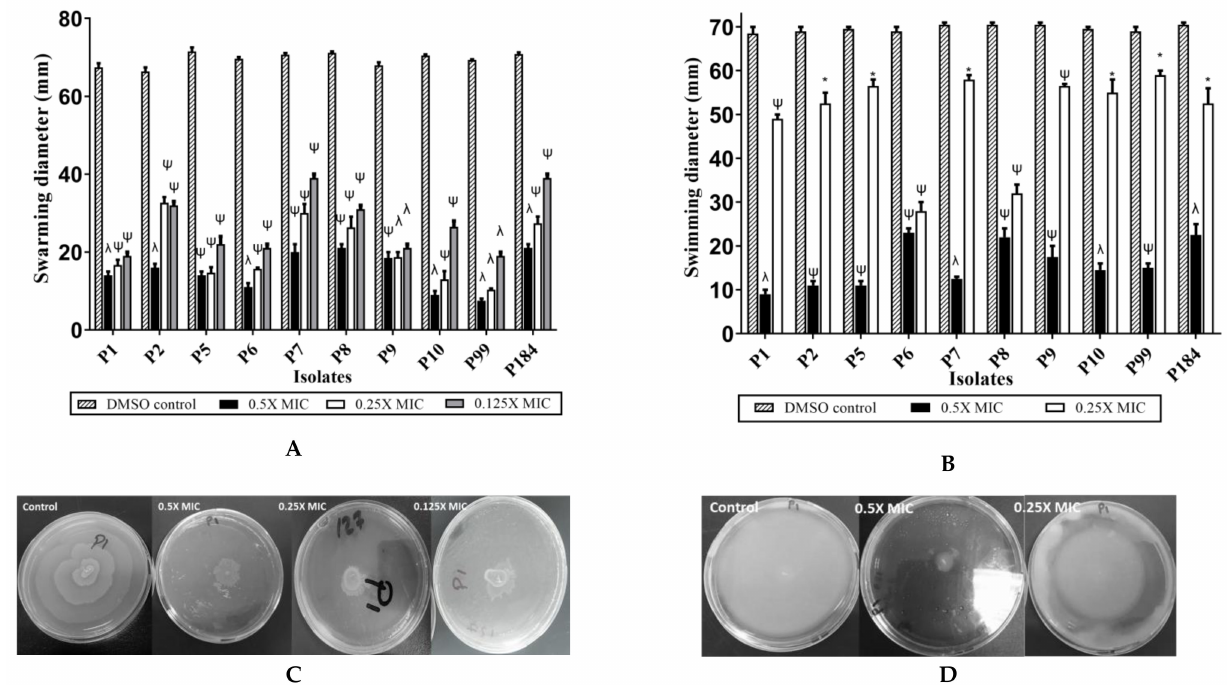
Figure 4. Inhibitory Effect of Zch127 culture extract on motility. The effect of Zch127 at sub-MICs on the motility of 10 P. mirabilis isolates ( A ) Swarming motility at 0.125X, 0.25X, and 0.5X MIC; ( B ) Swimming motility at 0.25X and 0.5X MIC, Data represents the mean of 3 experiments, and error bars shows standard error. Statistical difference was determined by student’s t -test, * p < 0.05; ψ p < 0.01; λ p < 0.001 compared with DMSO control; ( C ) Representative images of the effect of extract Zch127 on swarming motility of P. mirabilis isolate P1; ( D ) Representative images of the effect of extract Zch127 on swimming motility of P. mirabilis isolate